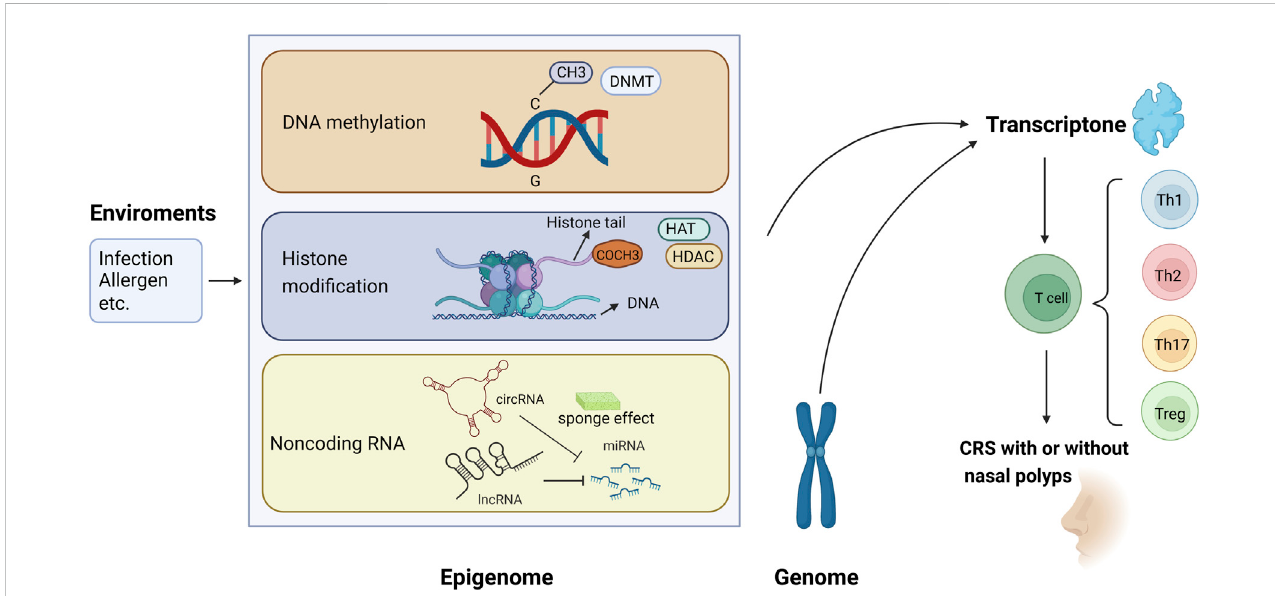
FIGURE 1 Epigenetic modi fi cations regulate gene expression and contribute to the pathogenesis of chronic rhinosinusitis (CRS) with or without nasal polyps. (1) Methyl group (CH3) on cytosines inactivates gene transcription, which is catalyzed by DNA methyltransferase (DNMT); in contrast, the DNA demethylation contributes to gene expression. (2) When acetyl groups (COCH3) bind to histone tails via histone acetyltransferase (HAT), the gene is expressed. Conversely, theremoval oftheacetylgroupsbyhistonedeacetylase(HDAC)turnsoffthegeneexpression.(3)circRNAandlncRNAcanregulatethe3 ′ -UTRofmRNA through the sponging effect of miRNA, then control the gene